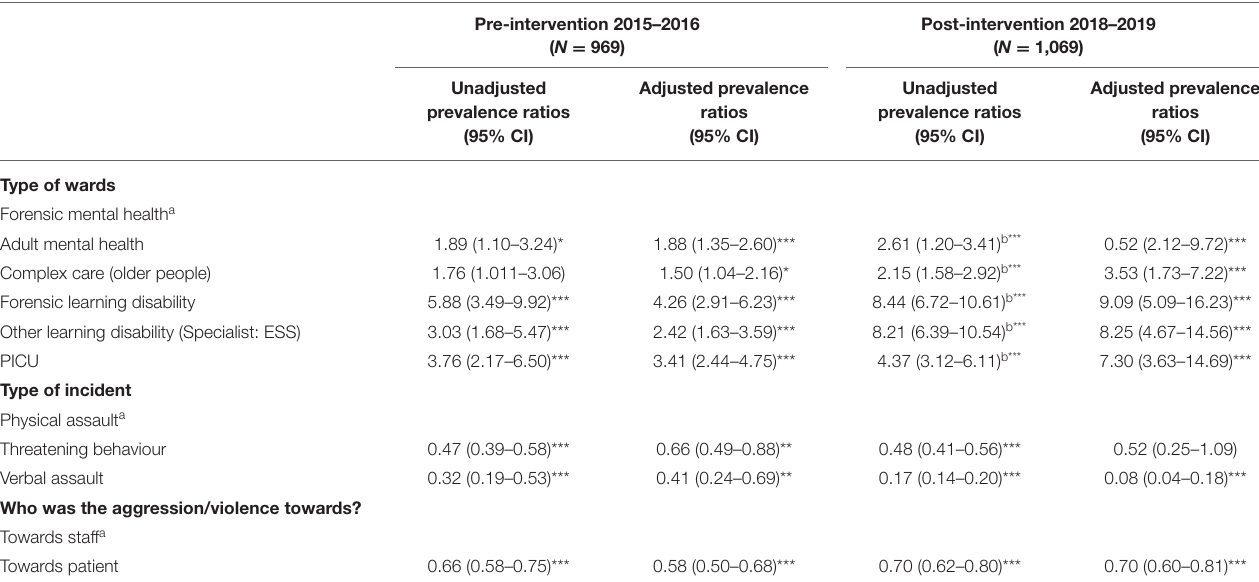
TABLE 4 | Prevalence ratio associated with physical